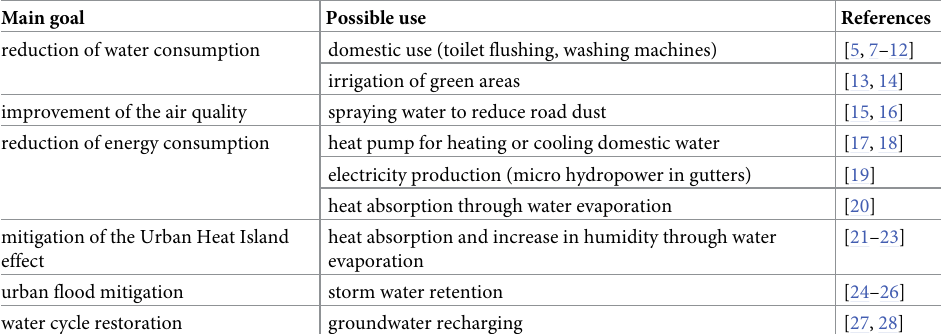
Table 1. Common uses of rainwater collected in an RWH